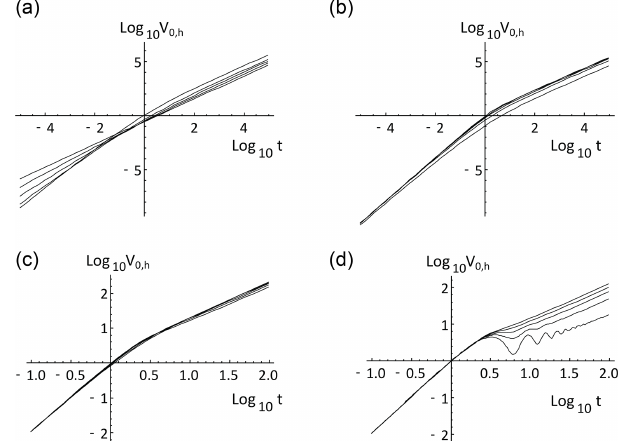
Figure 4. The normalized V 0 ,h functions for the various ranges of h for fRm. The plots from (a) to (d) are for the ranges 0 < h < 1 / 2, 1 / 2 < h < 1, 1 < h < 3 / 2, and 3 / 2 < h < 2. Within each plot, the lines are for h increasing in units of 1 / 10 starting at a value 1 / 20 above the plot minimum; overall, h increases in units of 1 / 10 starting at values 1 / 20 (a) to 39 / 20 (d) (e.g. for a , the lines are for h = 1 / 20, 3 / 10, 5 / 20, 7 / 20, and 9 / 20). For all h the large t behaviour is linear (slope = 1, although note the oscillations for the lower right-hand plot (d) for 3 / 2 < h < 2). For small t , the slopes are 1 + 2 h (0 < h ≤ 1 / 2) and 2 (1 / 2 ≤ h <